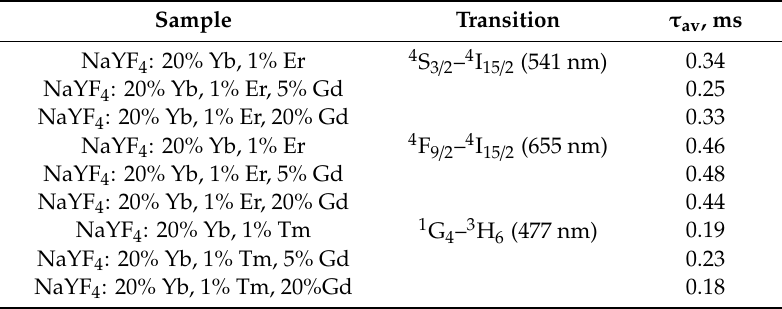
Table 1. Average luminescence lifetimes of Yb, 1% Er / 1% Tm, Gd microparticles. Sample